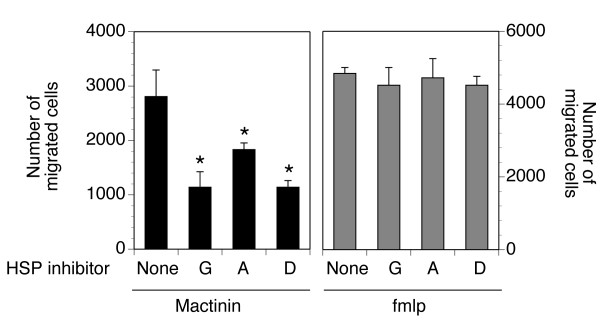
Mactinin-induced monocyte migration is blocked by Hsp90 Inhibitors. Monocytes were incubated with medium alone or with one of 3 Hsp90 inhibitors (G: geldanamycin; A: 17-AAG; D: 17-DMAG), prior to testing for mactinin-induced or fmpl-induced (control) chemotaxis. In the absence of mactinin or fmlp, 1302 +/- 122 cells migrated (not shown). Mactinin-induced migration was significantly inhibited by each of the Hsp90 inhibitors, whereas fmlp-induced migration was not. Data is shown as the mean +/- SEM. N = 3. Significance of differences in migration in the presence vs absence of Hsp90 inhibitors: *P < 0.01.